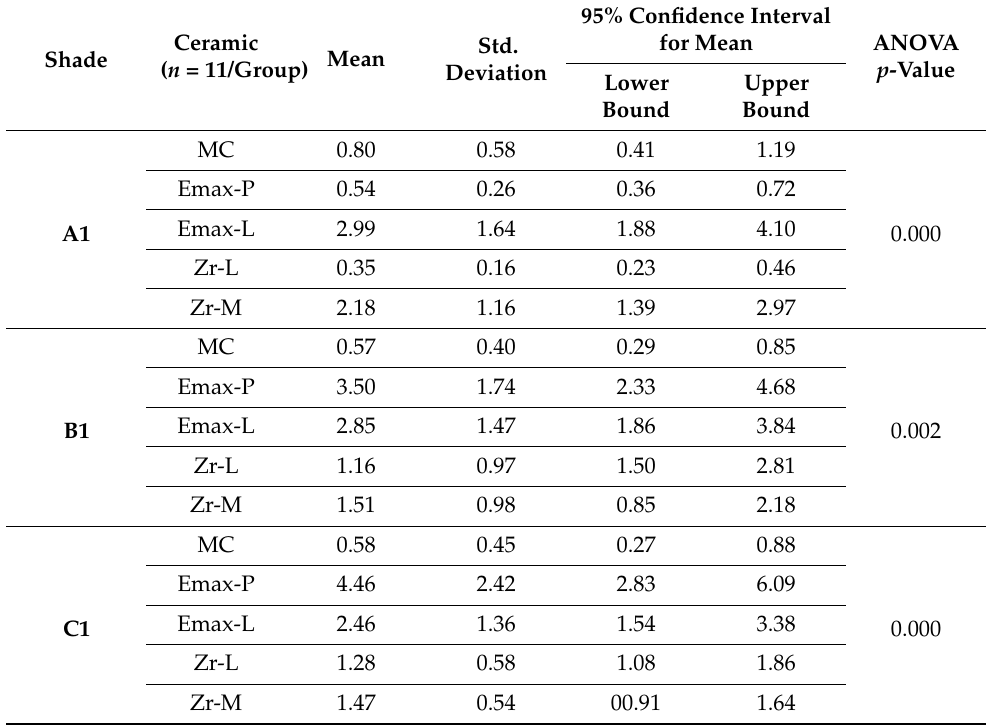
Table 4. Mean and standard deviation of the translucency parameter (TP) of the tested ceramic materials ( N = 165).